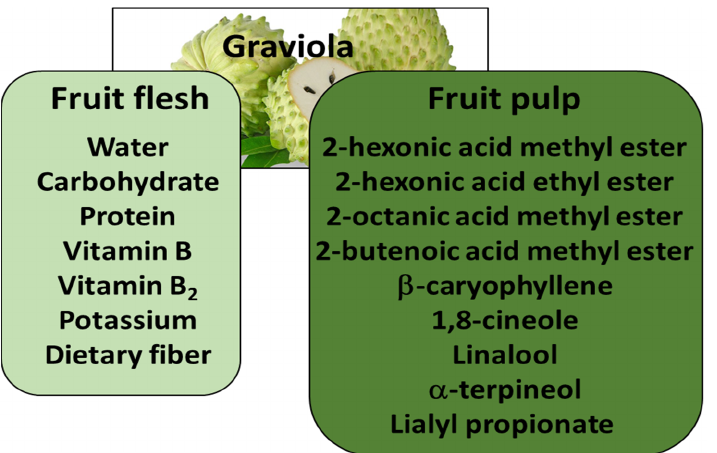
Figure 1. Chemical composition of graviola fruit flesh and fruit pulp (adapted from ref.: [1]).